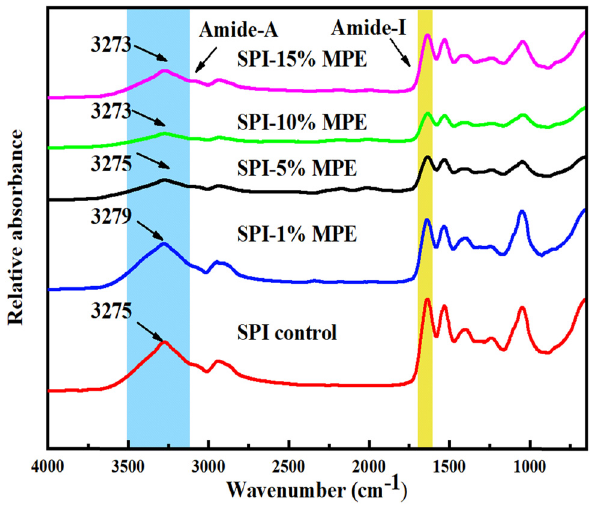
Figure 7: ATR - FTIR spectra of SPI fi lms with and without